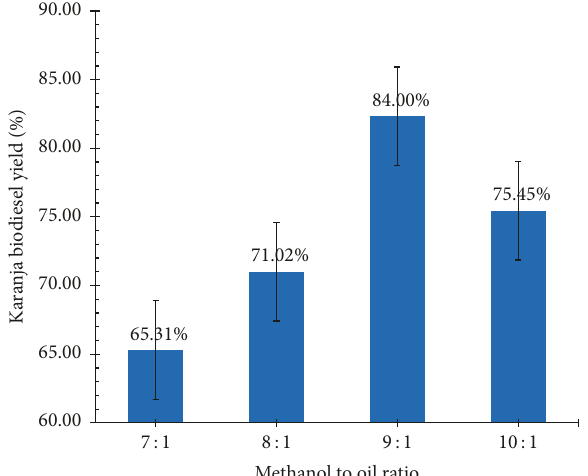
Figure 4: Biodiesel conversion by changing the particle size. Figure 5: Biodiesel conversion by changing methanol to oil ratio.